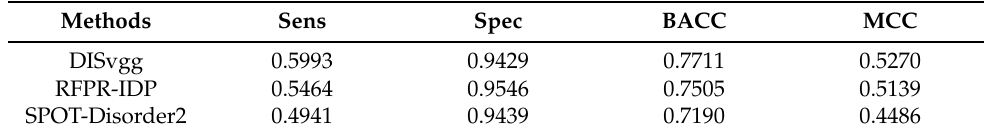
Table 2. Performance Parameters on Blind Test Dataset R80.